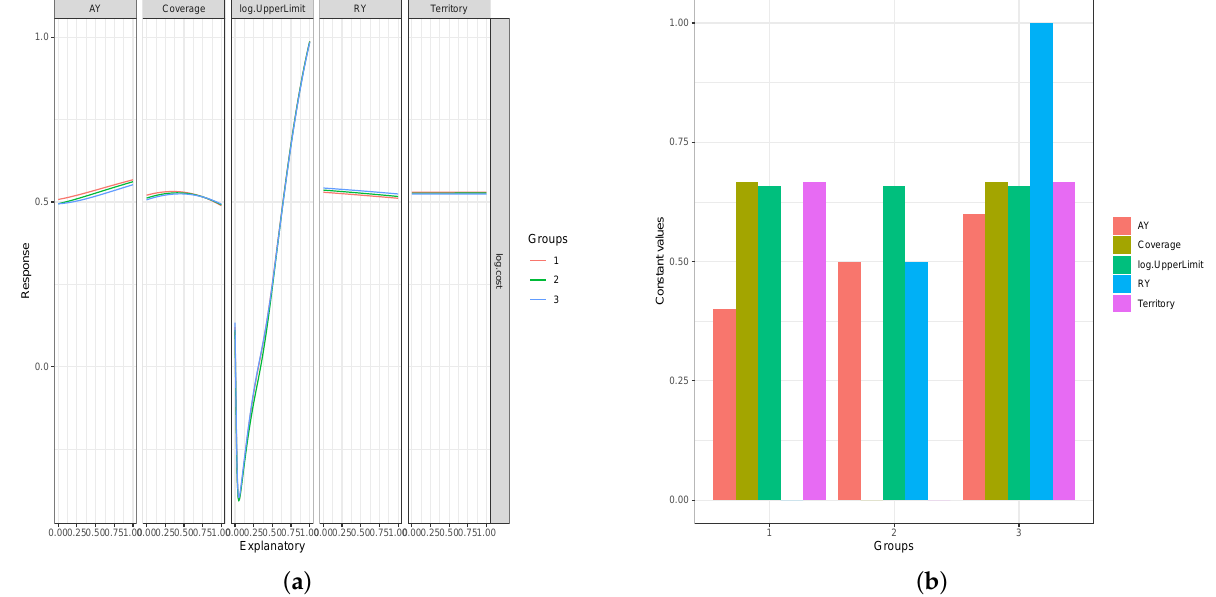
Figure 3. Bar plots for values of unevaluated risk factors in each group, where the group is at the cluster mean. ( a ) Claim Counts. ( b ) Loss